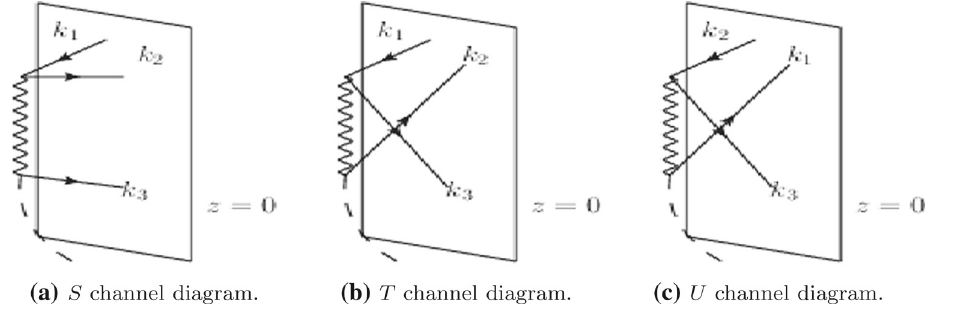
are attached to the boundary at z = 0. More precisely the wavy line denotes the bulk-to-bulk graviton propagator, the solid lines represent the bulk-to-boundary propagators for the scalar field and the dashed line denotes background represented by ∂ z ¯ φ